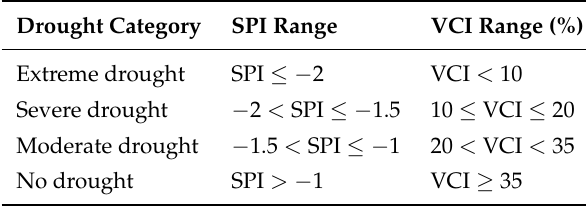
Table 2. Drought categories based on SPI [50] and VCI